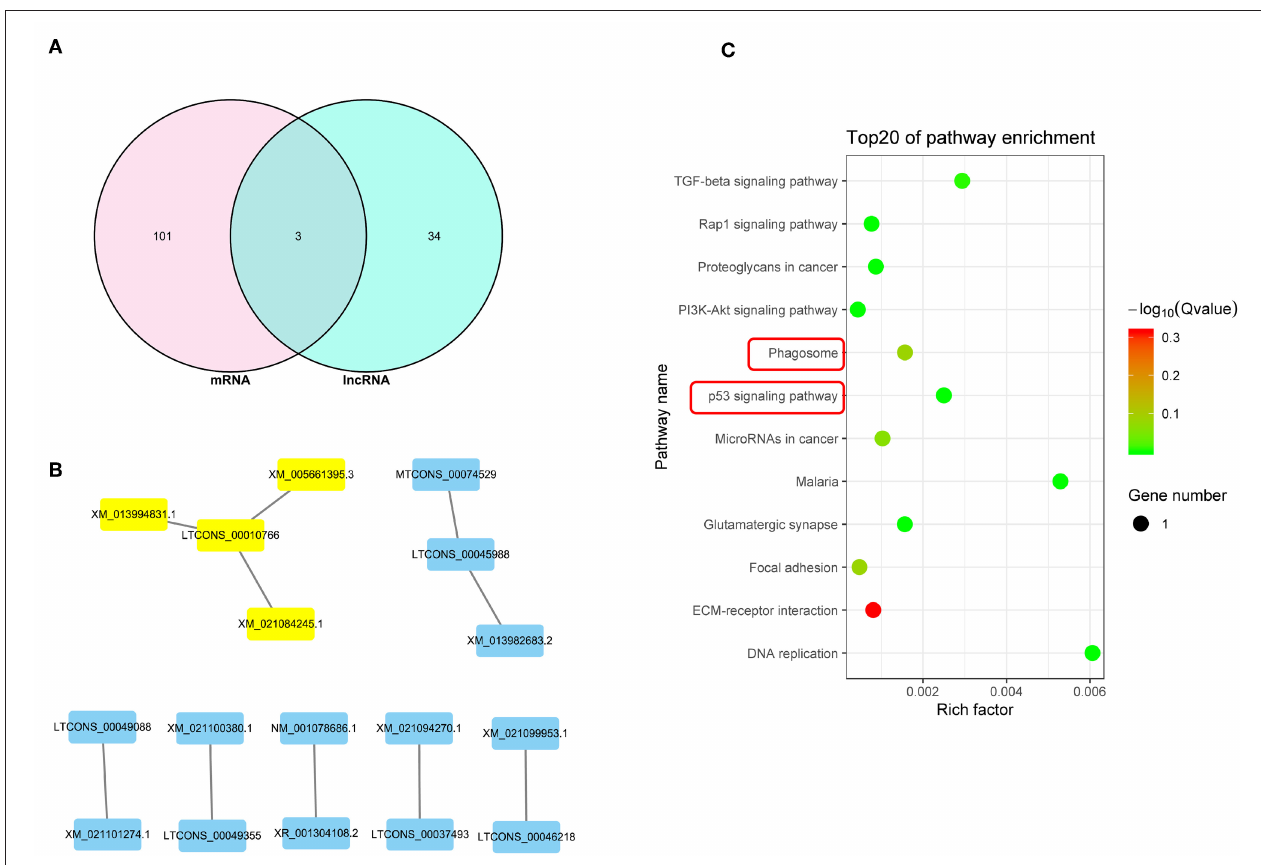
FIGURE 6 | Integrated analysis of DEGs and lncRNAs target genes. (A) Venn map analysis between DElncRNA target genes and DEGs.There are 3 co-expressed genes from the DEGs and DElncRNA target genes. (B) Regulatory relationship between DEGs and DElncRNAs.There are 8 DElncRNAs that related to the DEGs regulatory. (C) KEGG analysis based on reciprocal DElncRNAs and DEGs ( P < 0.05). The phagosome and p53 signal are the main pathway that related to cells apoptosis.